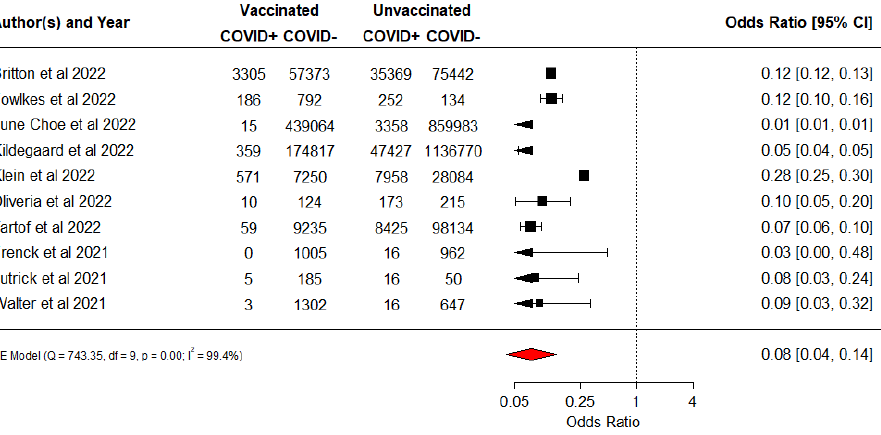
Figure 2. Vaccine effectiveness for all COVID infections [25–27,29–31,33,34,37,38]. The black square symbol presented for each study represents its point estimate, and the size is proportional to the weight of the study in relation to the pooled estimate. The red diamond symbol represents the overall effect estimate from the meta analysis.